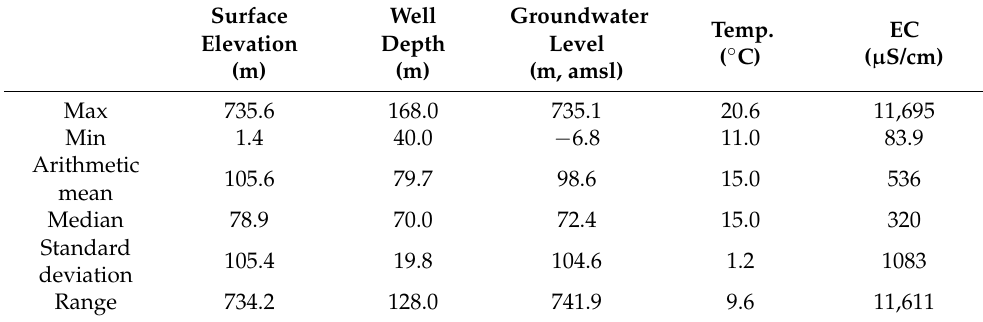
Table 1. Well information statistics in the Nakdong River watershed for